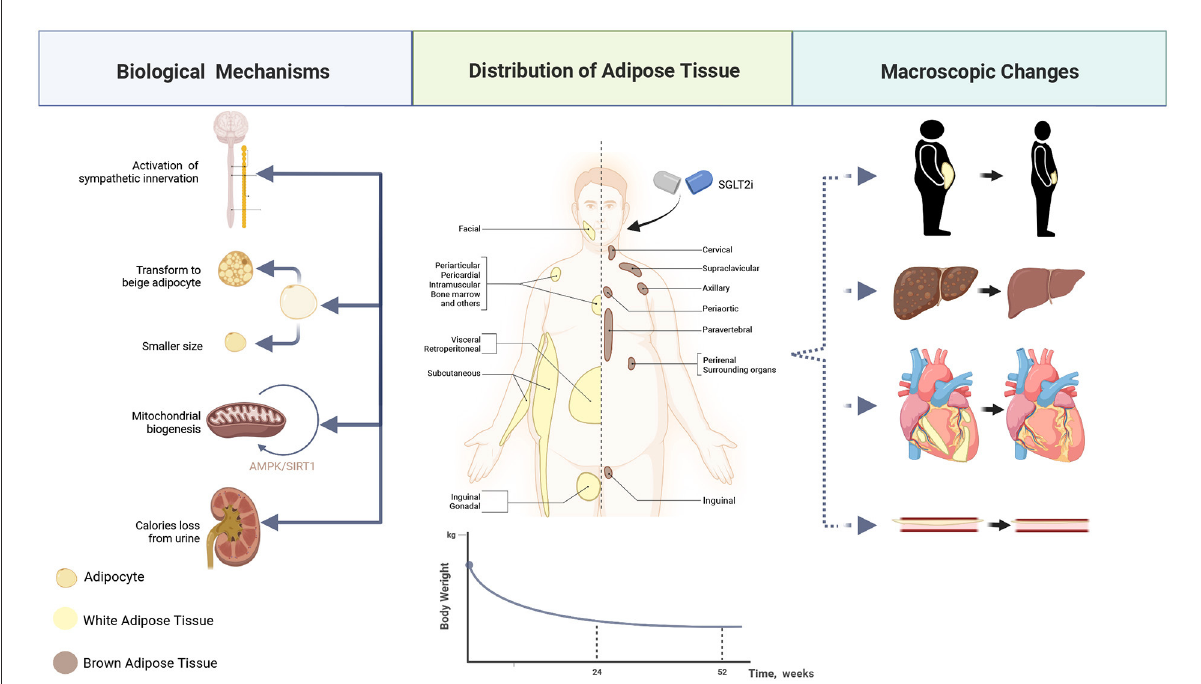
FIGURE2 Mechanisms of weight loss. Full view of how SGLT2i affects adipocytes—how to reduce the size, and how to stimulate its transformation to beige adipocytes, as well as how it makes the body pounds shed directly via calories loss. Consequently, the subcutaneous, visceral, and perivascular fat content decreases under the treatment of